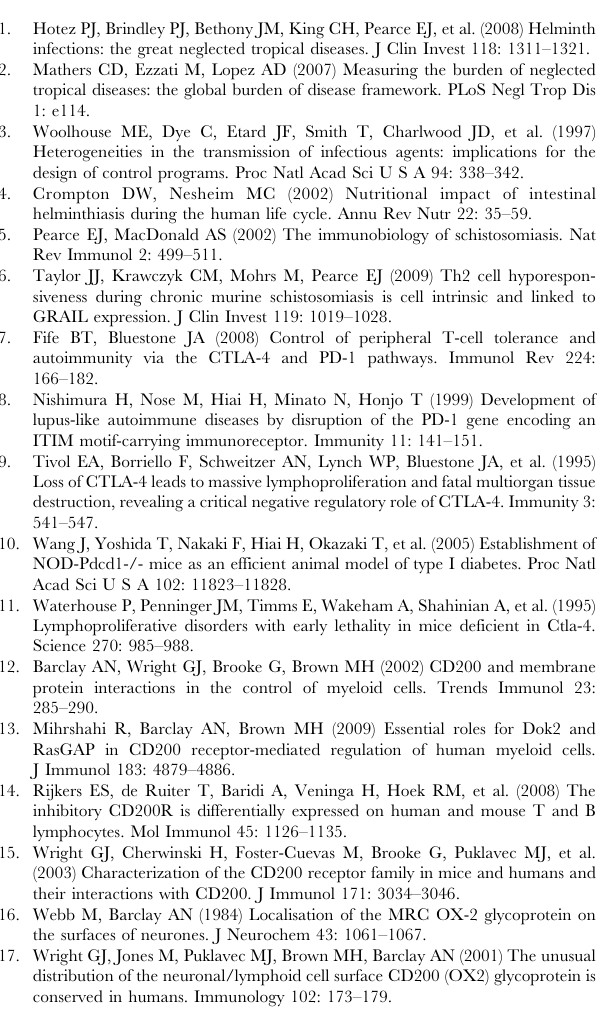
Figure S8 CD200R expression in vivo correlates in- versely with TNF a and IL-2 cytokine production. Bar graphs show (mean 6 SEM) detection of A. TNF a and B. IL-2